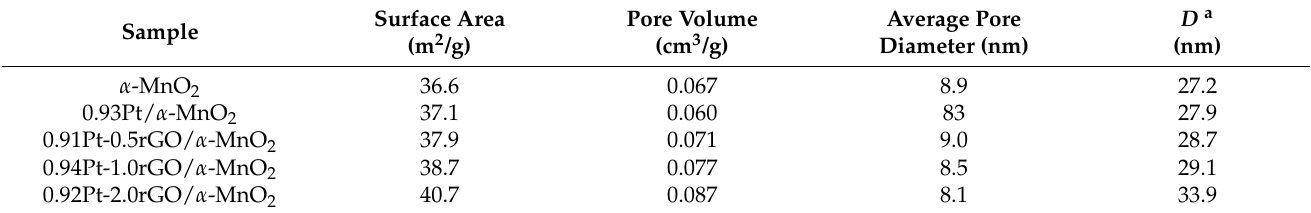
Table 2. Surface areas, pore volumes, average pore diameter, and crystallite sizes ( D ) of the